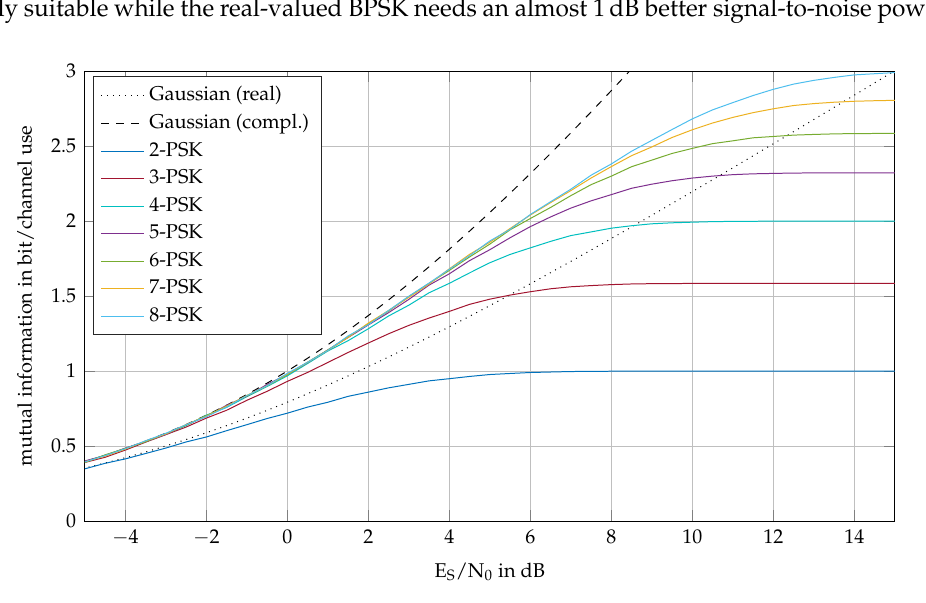
Figure 7. Mutual information for various PSK